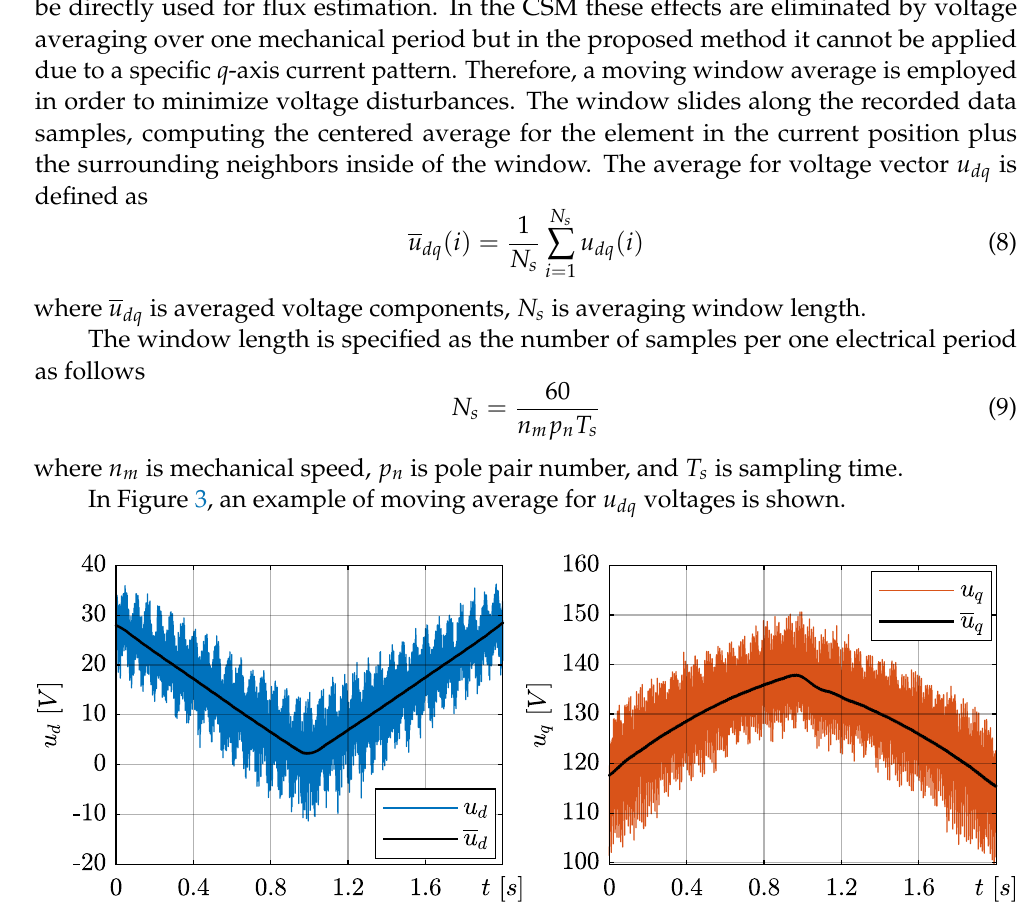
Figure 3. Voltage moving average for i d = 40 A, i q = 0..40